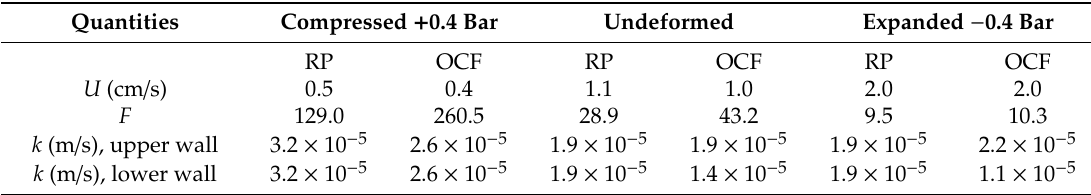
Table 5. Approach velocity, Darcy friction factor, and mass transfer coefficients for the undeformed, + 0.4 bar compressed and − 0.4 bar expanded configurations for an RP with P / H = 10 and OCF with P / H = 8 [20] geometries with γ = 90° and Re τ = 2.5.